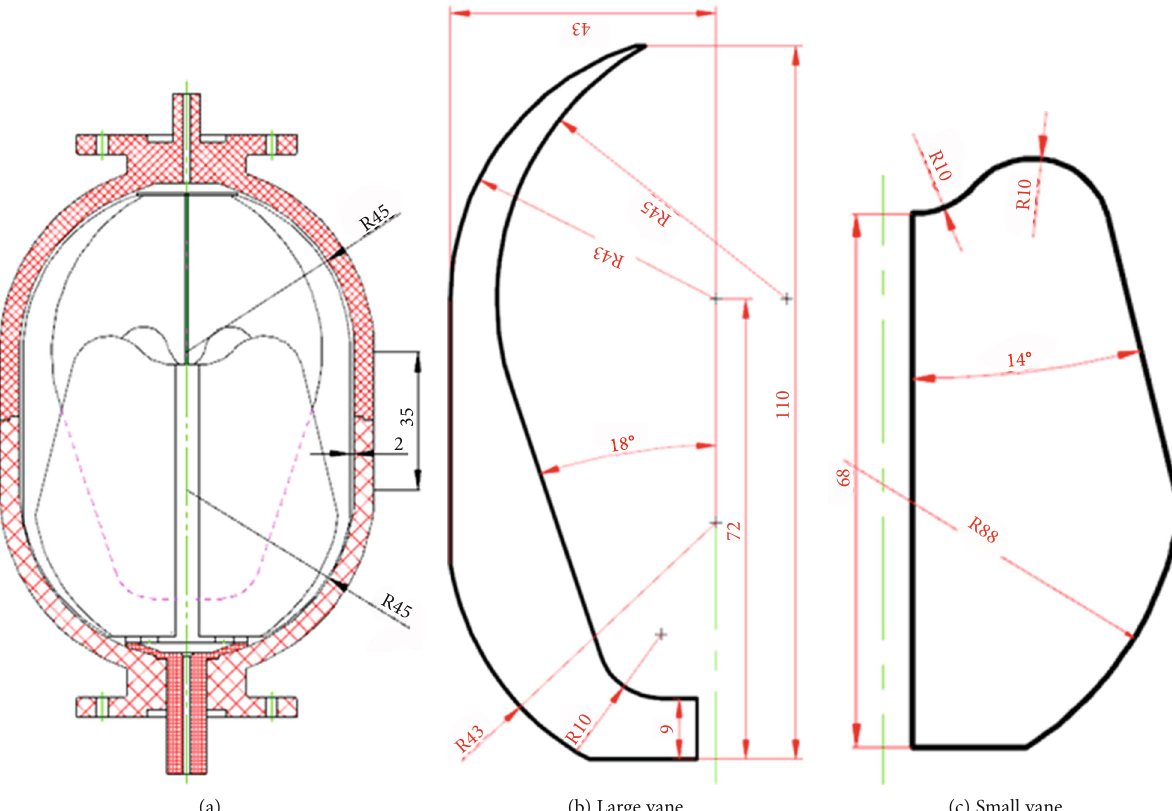
Figure 3: Vane-type propellant tank